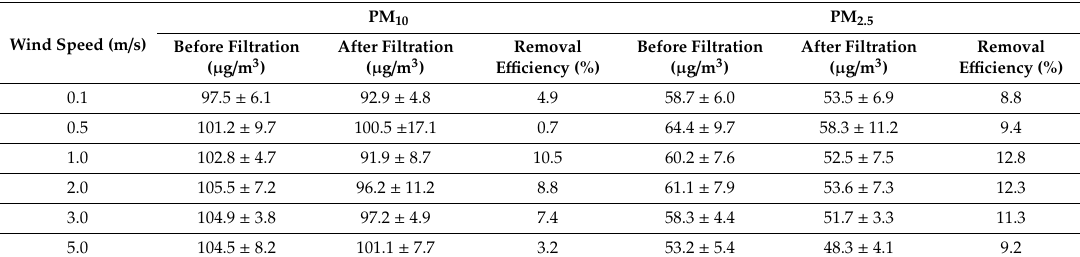
Table 2. Average fine particulate matter (PM) removal e ffi ciency of the ACF filter for di ff erent wind speeds at an ACF depth of 200 mm.